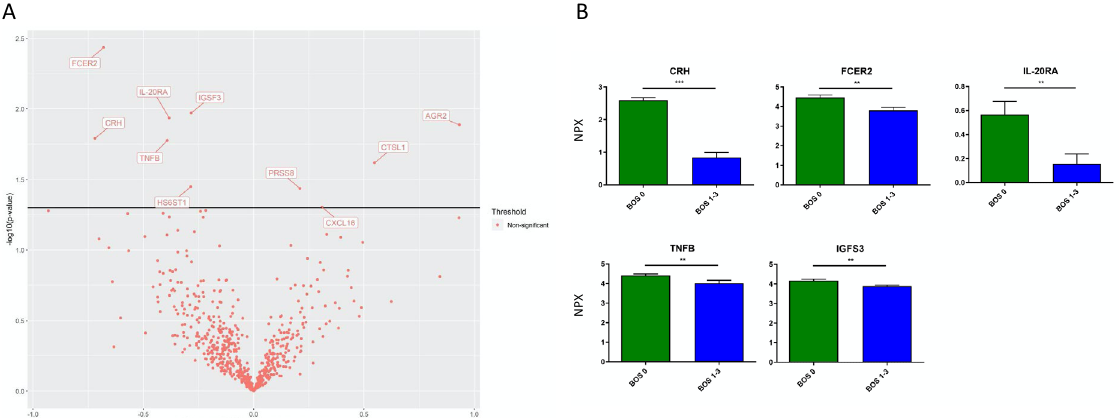
Figure 2. Detection of Biomarker Candidates Using Proximity Extension Assay. Patient samples were categorized as either a BOS grade 0 or a BOS grade 1–3. ( A ) Shows a volcano plot of the 644 proteins analysed using the proximity extension assay. A linear regression model compared the two groups with the solid line indicating a p value of 0.05. Proteins on the positive x-axis have higher NPX values in the BOS grade 1–3 group, and proteins on the negative x-axis have higher NPX values in the BOS grade 0 group. ( B ) Shows mean and SEM of five of the most significant proteins. These protein levels were all significantly lower among patients with BOS compared to those with grade 0. ** p < 0.01, *** p < 0.001. CRH, corticotropin releasing hormone; FCER2, low affinity immunoglobulin epsilon Fc receptor; IL-20RA, Interleukin-20 receptor subunit alpha; TNFB, TNF-